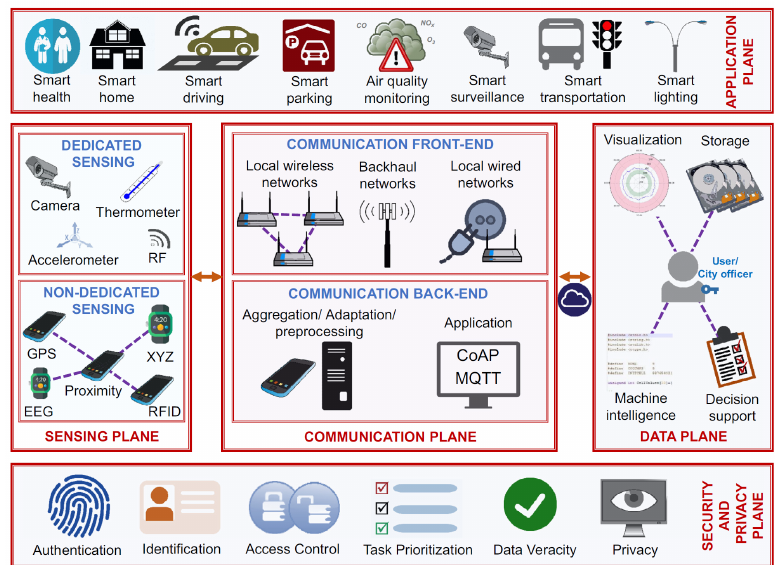
Figure 6. Smart city architecture defined in five planes: application (connects city and citizens), sensing (sensors measurements), communication (cloud services), data (processing and analysis) and security and privacy planes (assurance of security and privacy)